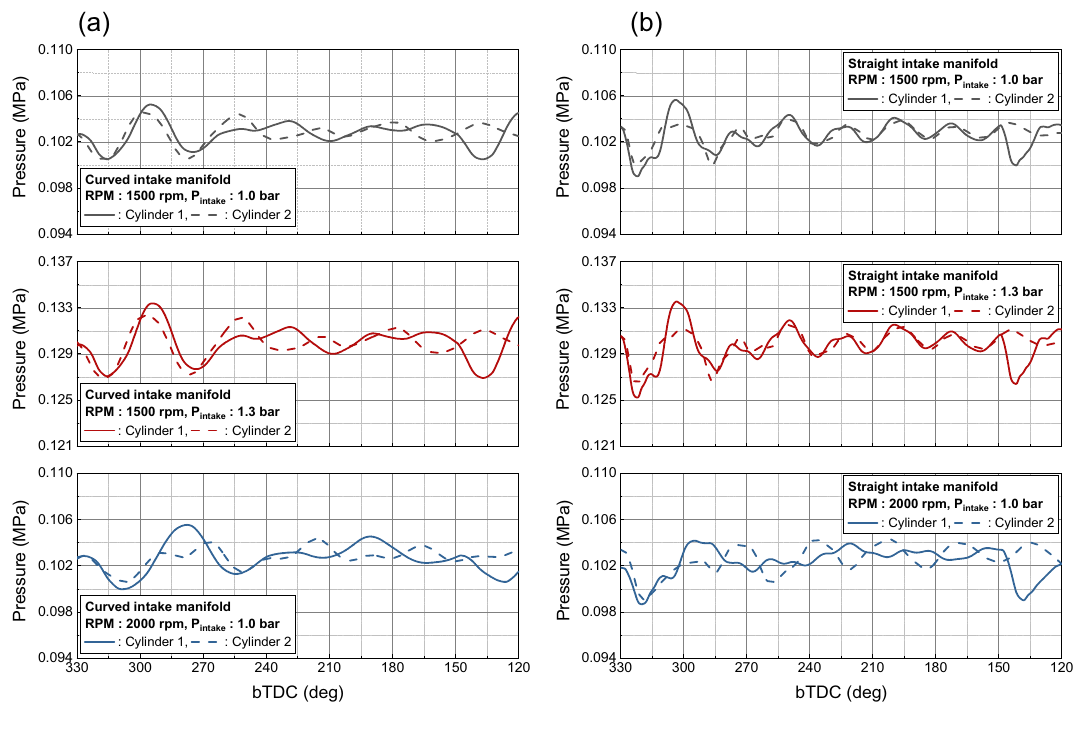
Figure 13. Pressure fluctuation in intake manifold for different intake manifold: ( a ) curved manifold, ( b ) straight manifold.